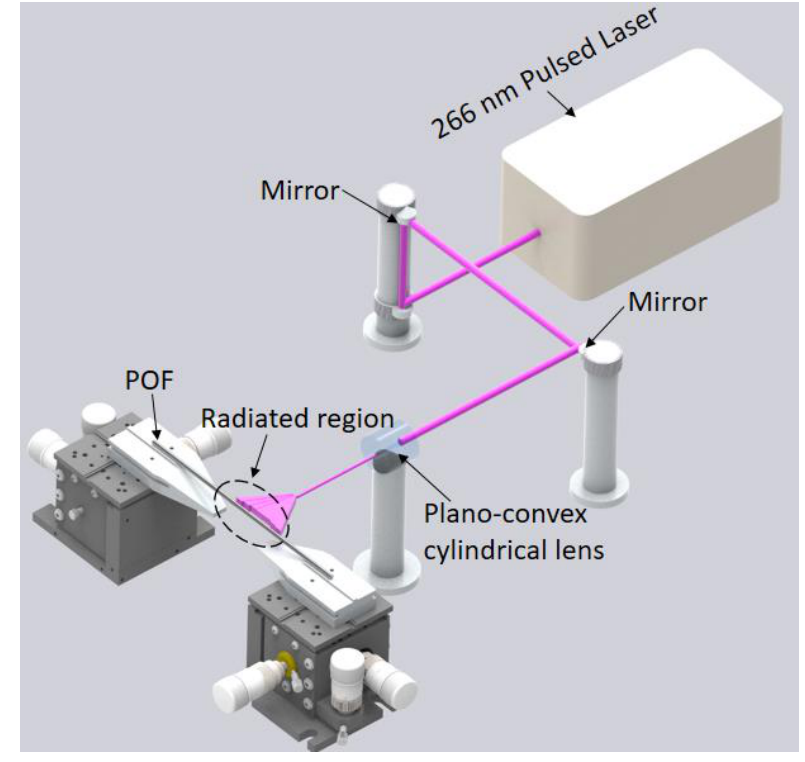
Figure 1. Experimental setup for UV radiation in the POF samples.